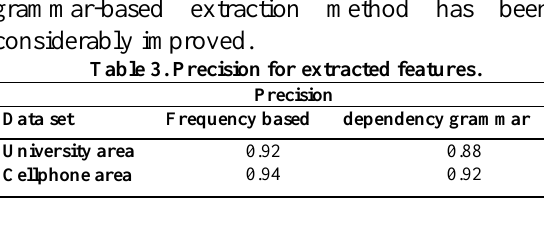
Table 4. Recall for extracted features. Recall Table 5. F-measure for extracted features.